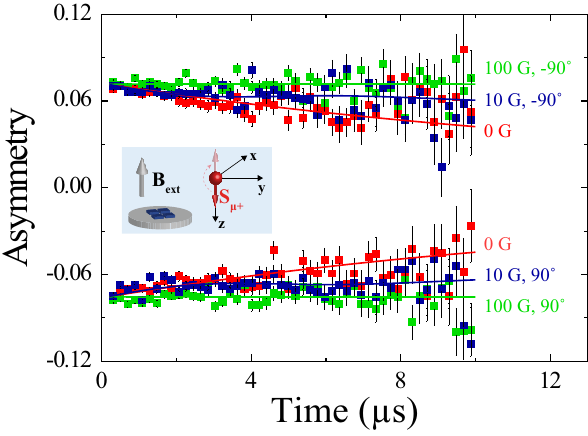
Fig. 4 Static nature of magnetism in SRO 214 . Asymmetry signal measured at T = 5 K in ZF/LF for parallel (angle = 90°) and antiparallel (angle = − 90°) alignments of the applied fi eld B ext and the muon spin polarization S μ + with different B ext amplitude values: B ext = 0 G (red symbols with error bars), B ext = 10 G (blue symbols with error bars) and B = 100 G (green symbols with error bars). The inset schematic shows ext the relative orientation of B ext and S μ + in our orthonormal reference-axes Fig. 3 Magnetic fi eld response and depth pro fi le of magnetism in SRO 214 . system for the ZF/LF a , b , Temperature dependence of the local fi eld amplitude B loc ( a ) and of the shift in the depolarization rate, Δ λ , from the λ value measured at T = 200 K ( b ) measured in TF with amplitude of the external fi eld B = 1500 G at E = 3 keV (red symbols with error bars) and E = 14 keV ext (blue symbols with error bars). Error bars in ( a ) are within the symbols. The inset schematic in ( a ) shows the relative orientation of the applied fi eld B ext with respect to the muon spin polarization S μ + in our orthonormal reference-axes system for the TF con fi guration. The Δ λ values in ( b ) are different from those shown in Fig. 2, as they are measured at a different stage of the experiment after warming the samples to room T , degaussing the magnet and zero- fi eld cooling the samples again before applying B ext . c , d Shift in the local fi eld amplitude Δ B loc ( c ) and in Δ λ ( d ) between T = 100 K > T T = 5 K < T E for on and on measured in TF as a function of B = 100 G (green symbols with error bars) and B = 1500 G (purple ext ext symbols with error bars). The top axes are the corresponding muon average stopping depth (cid:1) z values determined from the simulated muon stopping distributions in Fig. 1d. Dashed lines in ( b ) to ( d ) are guides to the eye.